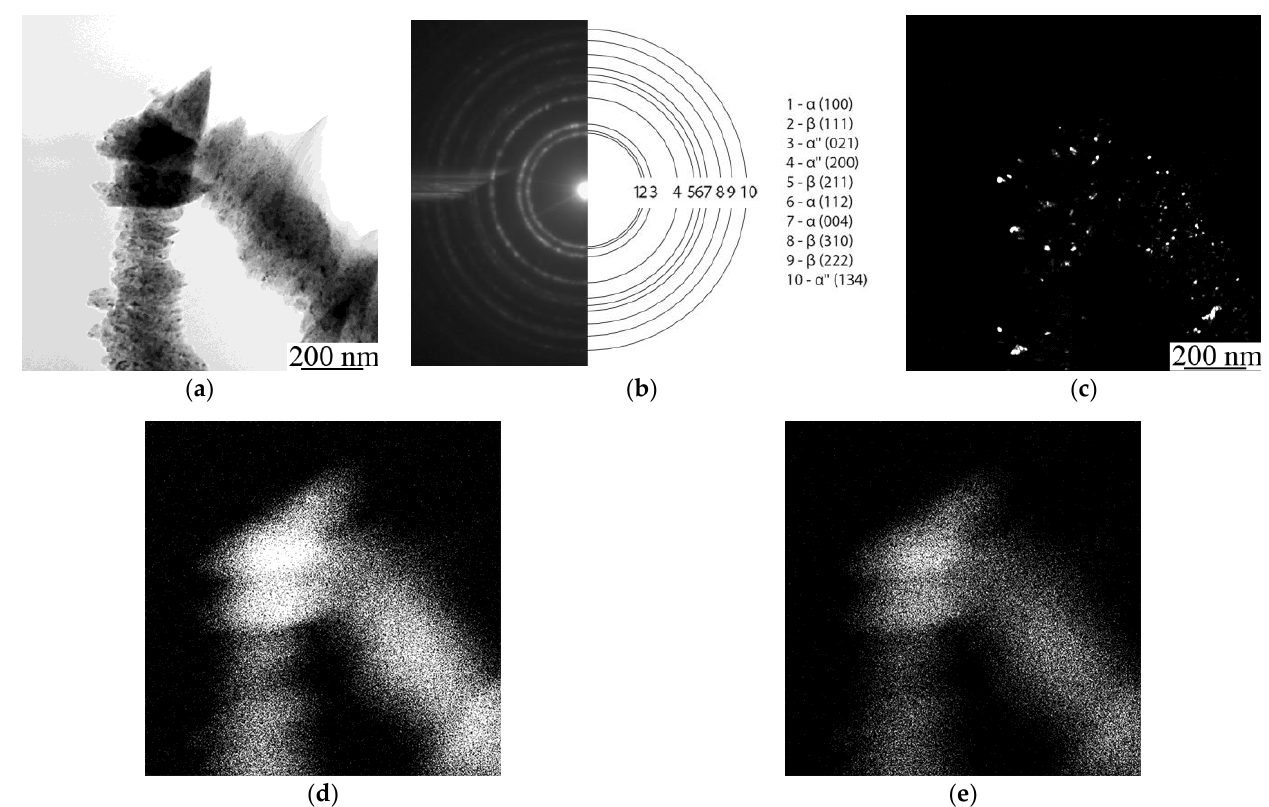
Figure 6. ( a ) TEM light-field image, ( b ) SAED pattern, ( c ) dark-field image in combined α(100) and β(111) reflex and maps of elements’ distribution: ( d ) titanium and ( e ) niobium.